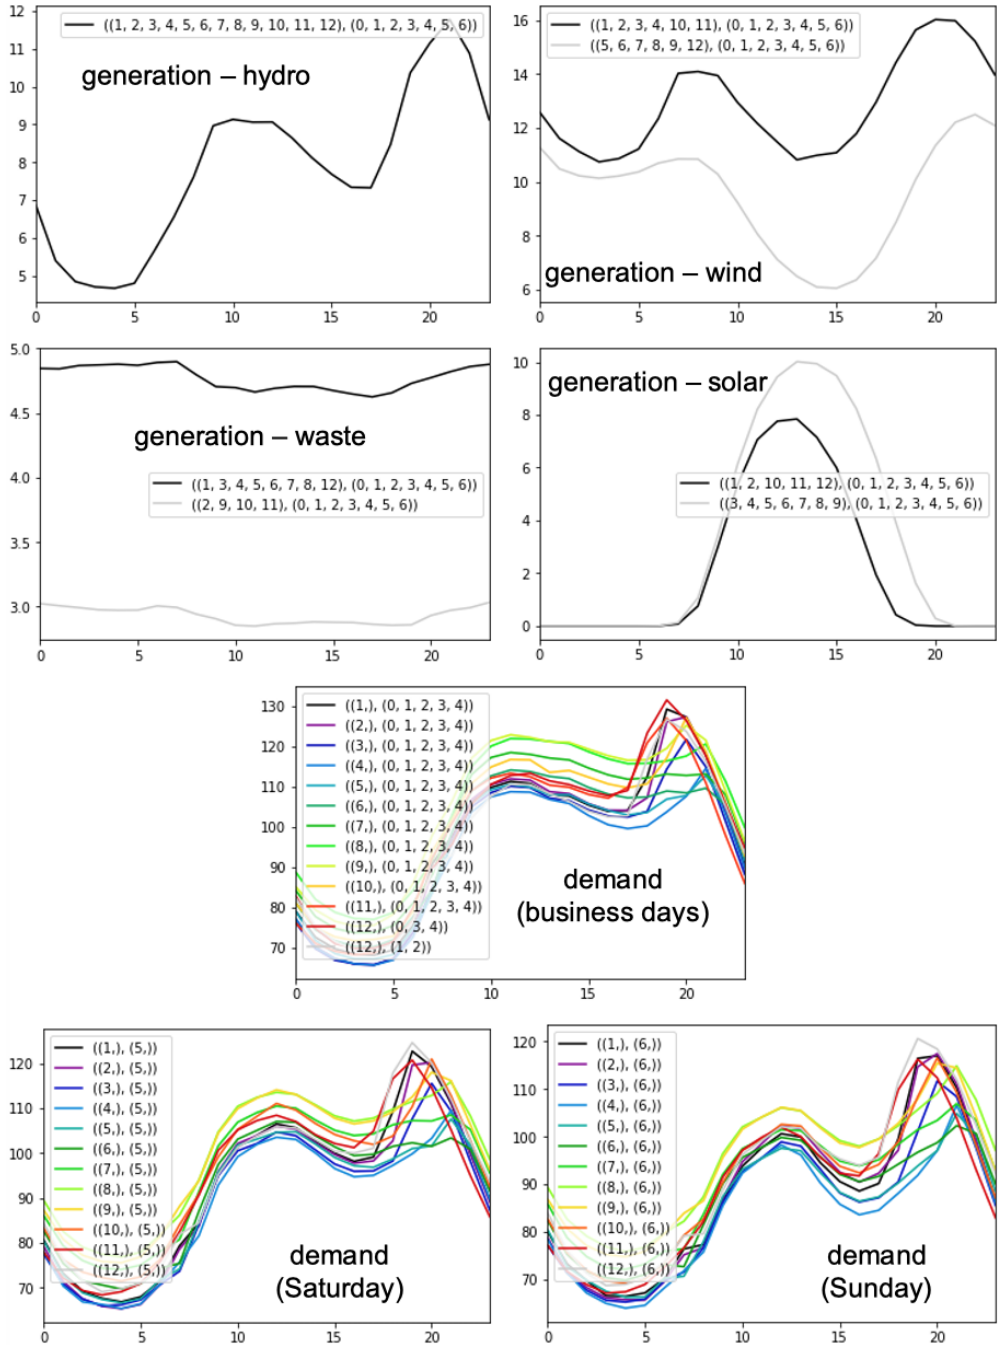
Figure A3. Average time profiles of power data from Madeira. The horizontal axes represent time of the day (h), and the vertical ones power (MW). The legends explain the clustering groups in the form (months, days of week), where days are numbered from 0 (Monday) to 6